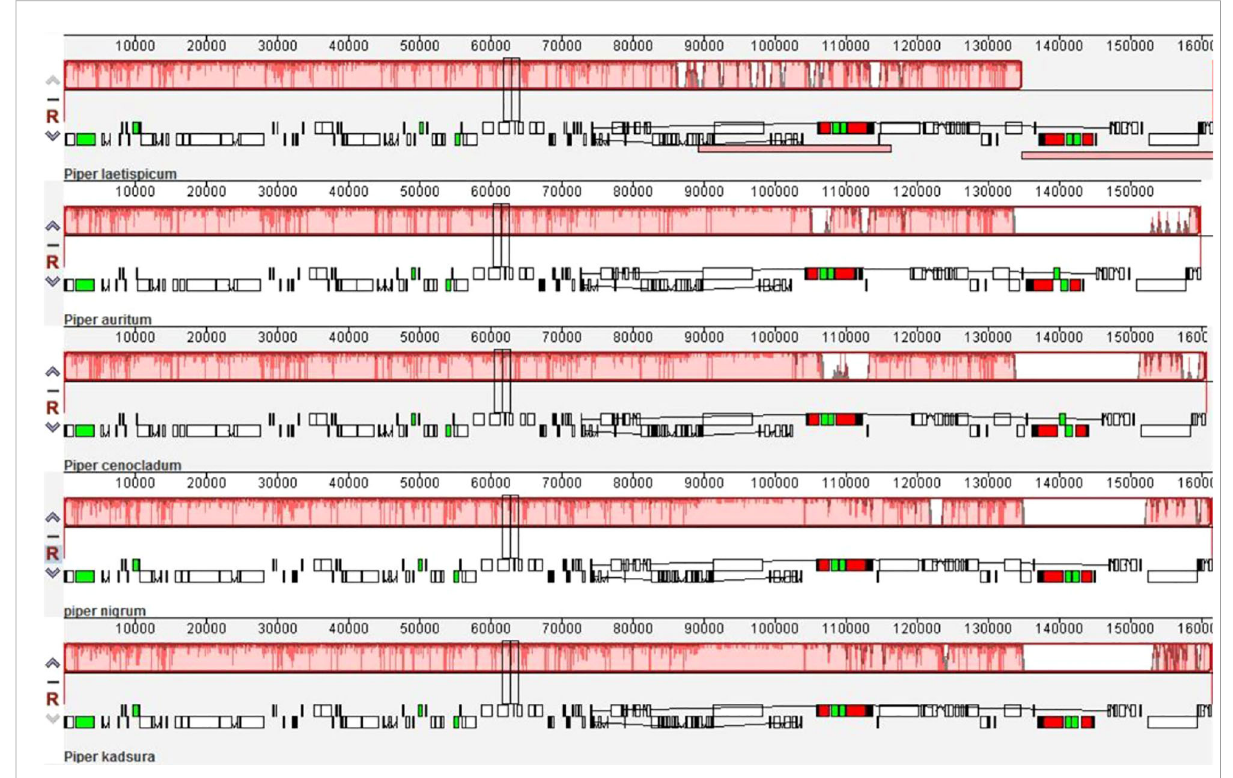
FIGURE 8 Gene order comparison of the chloroplast genome within Piperaceae.